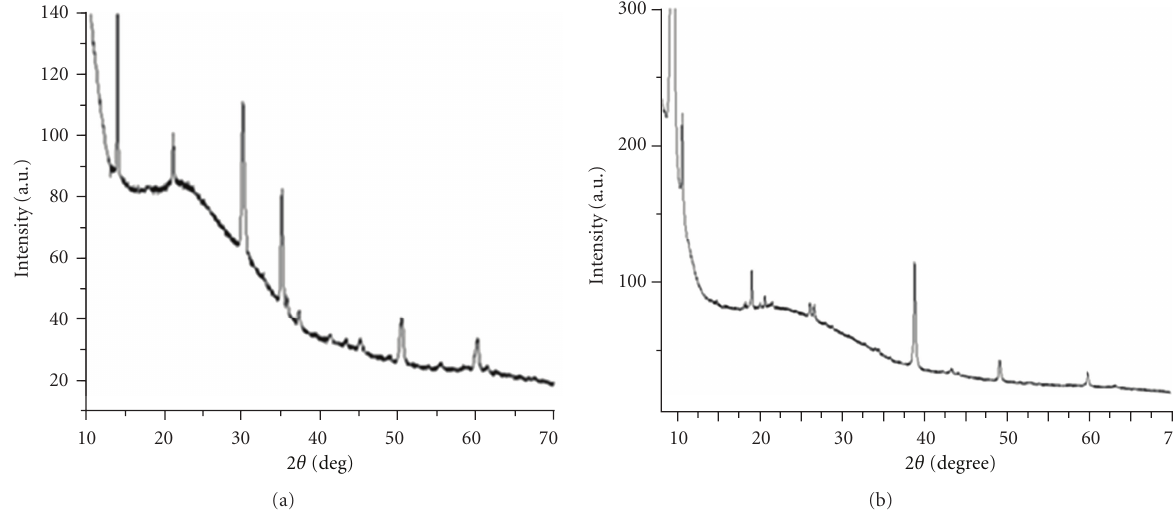
Figure 11: XRD spectra of poly(AnPS- co -An) (a) and poly(DAnPS- co -An)